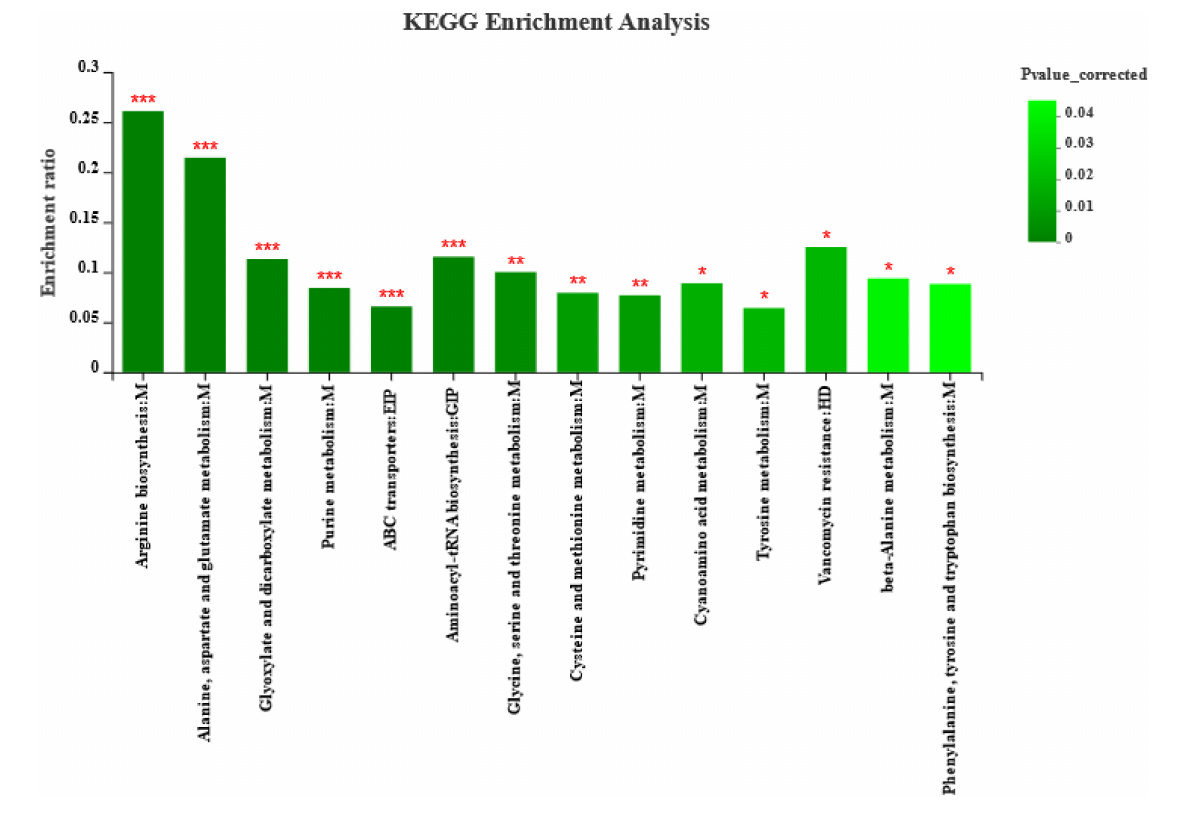
FIGURE6 Metabolite pathway enrichment analysis following positive and negative mode ionization. Overview of metabolites enriched in ryegrass after silage of different harvests. M, EIP, GIP, and HD are the class names of metabolic pathways in KEGG annotation. M, Metabolism; EIP, Environmental Information Processing; GIP, Genetic Information Processing; HD, Human Diseases. p -value-corrected < 0.05 and column chart showing p -values for the top 20 pathways; * p < 0.05; ** p < 0.01; *** p <